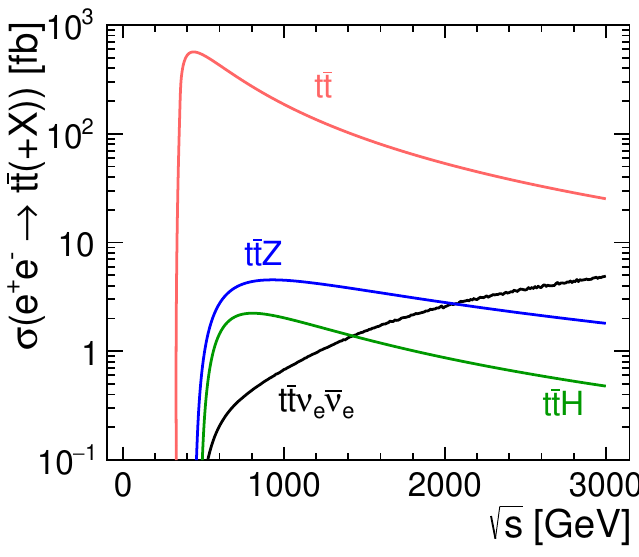
Figure 3. Cross section as a function of centre-of-mass energy for the main top-quark pair produc- tion processes at an e + e (cid:0) collider for a top-quark mass of m of m = 125 GeV. The leading-order expectations for unpolarised beams with ISR are shown. The H e(cid:11)ect of beamstrahlung is not